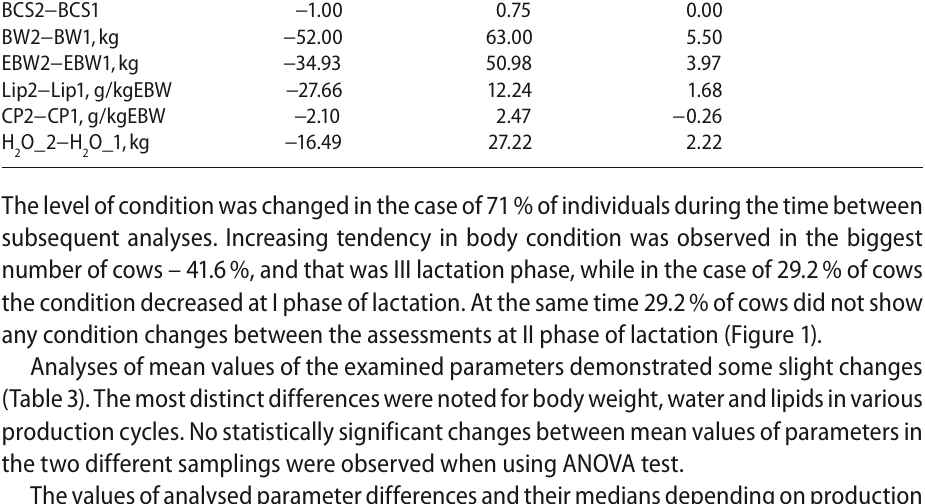
Changes of analysed parameters Difference Min Max Median BCS2−BCS1 −1.00 0.75 0.00 BW2−BW1, kg −52.00 63.00 EBW2−EBW1, kg −34.93 Lip2−Lip1, g/kgEBW −27.66 CP2−CP1, g/kgEBW −2.10 2.47 −0.26 H O_2−H O_1, kg −16.49 27.22 2 2